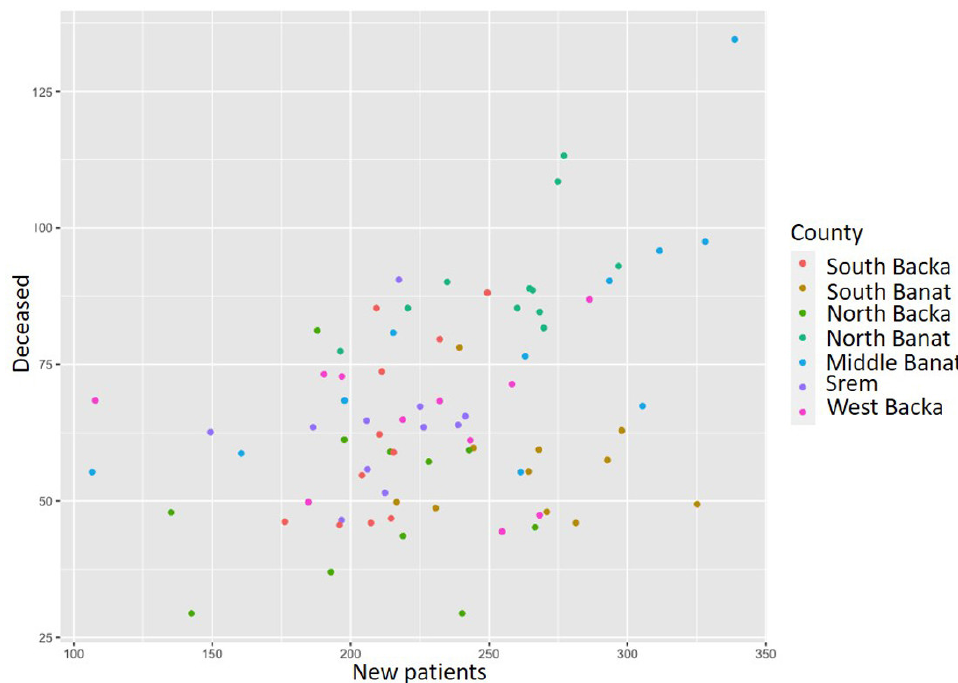
Figure 7. Myocardial infarction incidence and mortality rate ratio from 2010 to 2020.